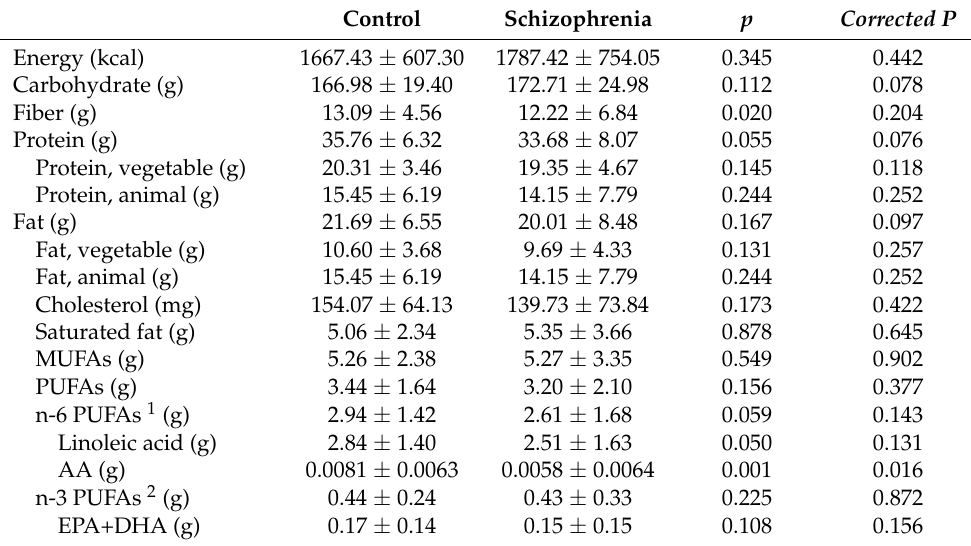
Table 3. Dietary intakes of energy and energy-adjusted dietary intakes (per 1000 kcal) of carbohydrate, protein, and